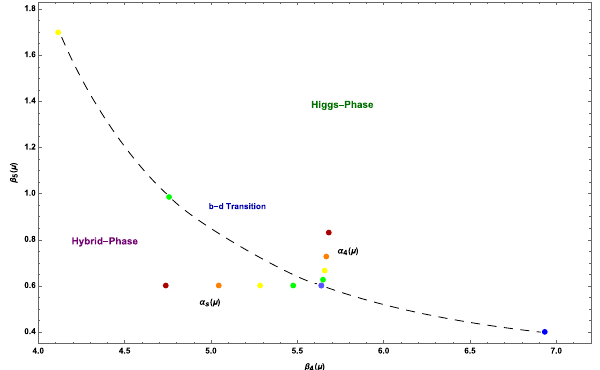
Fig. 10 Zoom around the phase transition for the SM-like example in Eq.(4.32).Thecolourcodeconventionregardingthescalevalueofeach point follows light frequencies